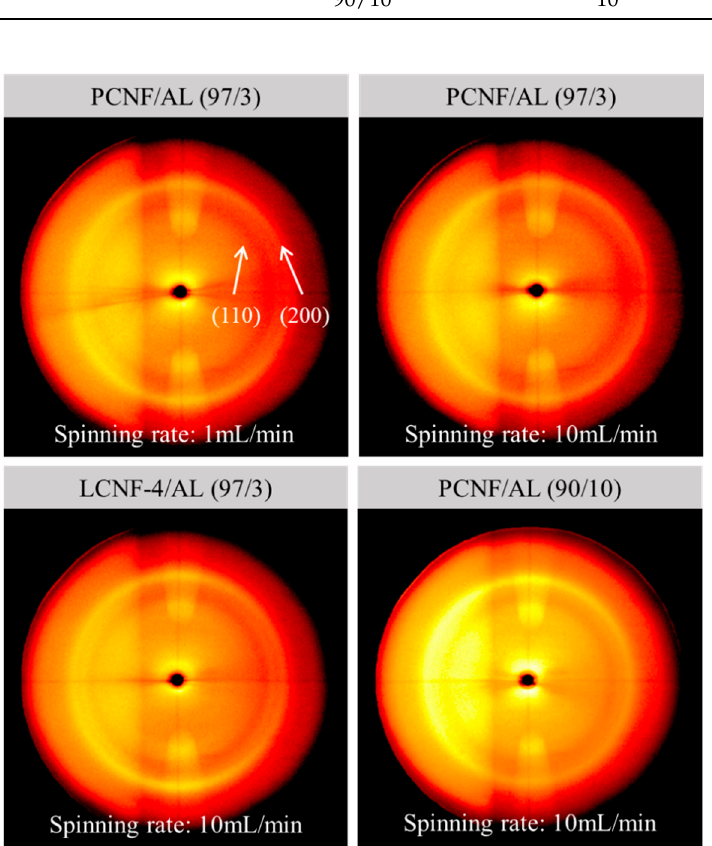
Figure 5. 2D XRD patterns of wet-spun composite filaments made of PCNF/AL and LCNF-4/AL with different AL contents and spinning rates.